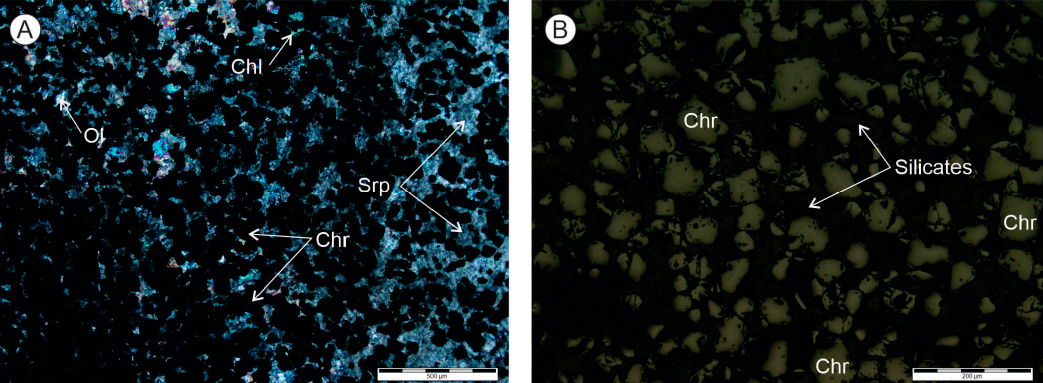
Figure 8. Photomicrographs of massive chromite ore from the Peridotitic Chromitite Mineralized Zone showing various silicate minerals and chromite. ( A ) Chlorite and serpentine forming networks around chromite grains; ( B ) Olivine, serpentine, and chlorite forming networks around chromite grains. The scale bar at the bottom right corner of the image represents 500 µm. Refer to Figure 2 for explanation of the mineral abbreviations.